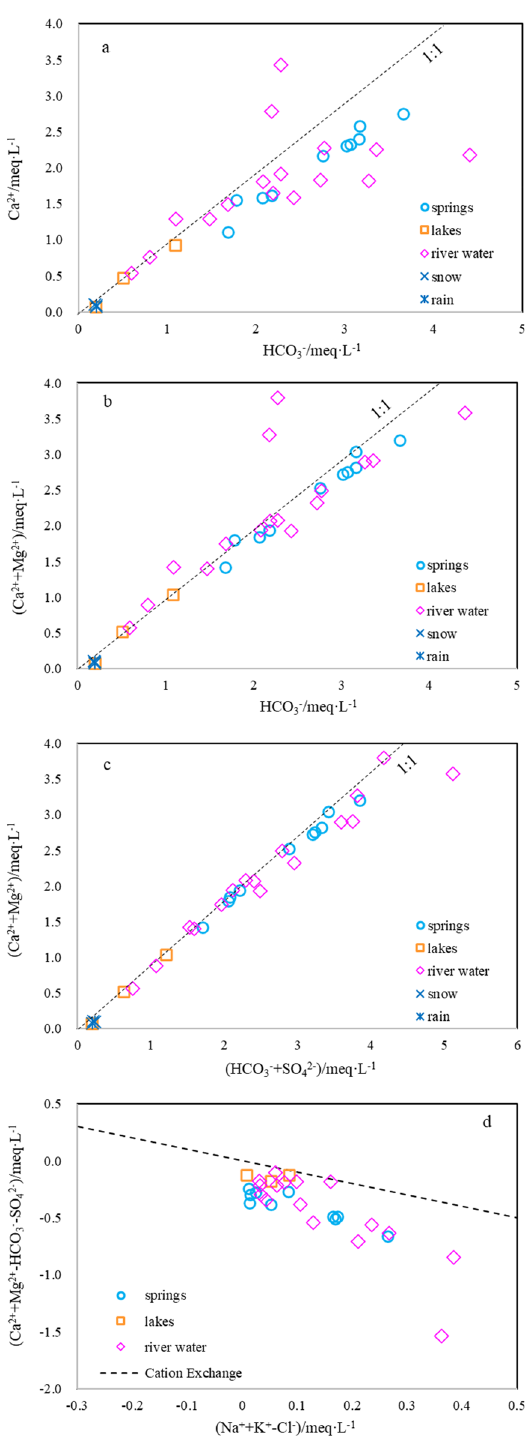
Figure 10. Ionic relationships of the main water groups in the study area: ( a ) HCO 3- vs. Ca 2+ , ( b ) HCO 3- vs. Ca 2+ + Mg 2+ , ( c ) HCO 3− + SO 42− vs. Ca 2+ + Mg 2+ , and ( d ) Na + + K + –Cl − vs. Ca 2+ + Mg 2+ –HCO 3– SO 42-